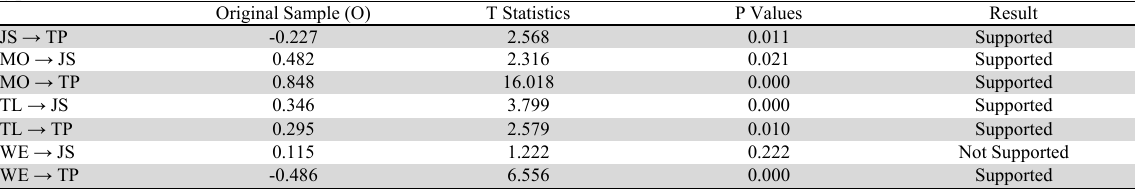
Hypothesis Result of the Structural Model Original Sample